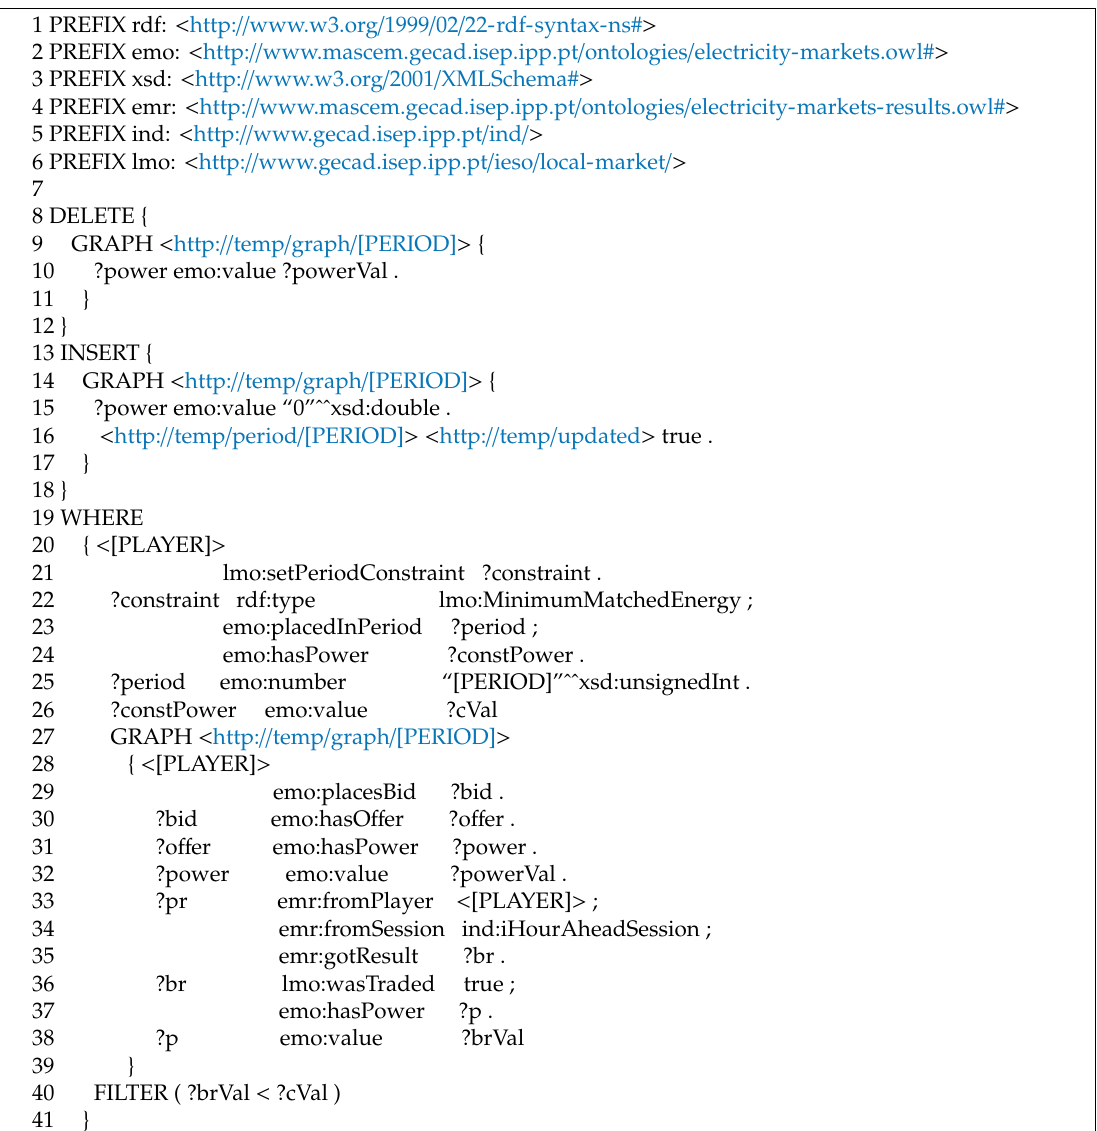
Listing 5. Period’s Minimum Matched Energy SPARQL